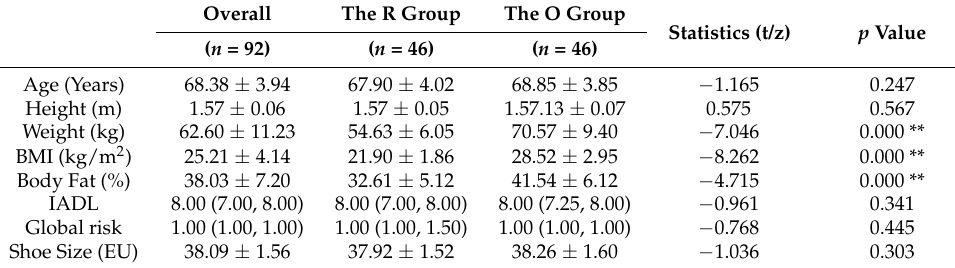
Statistics (t/z) p Value